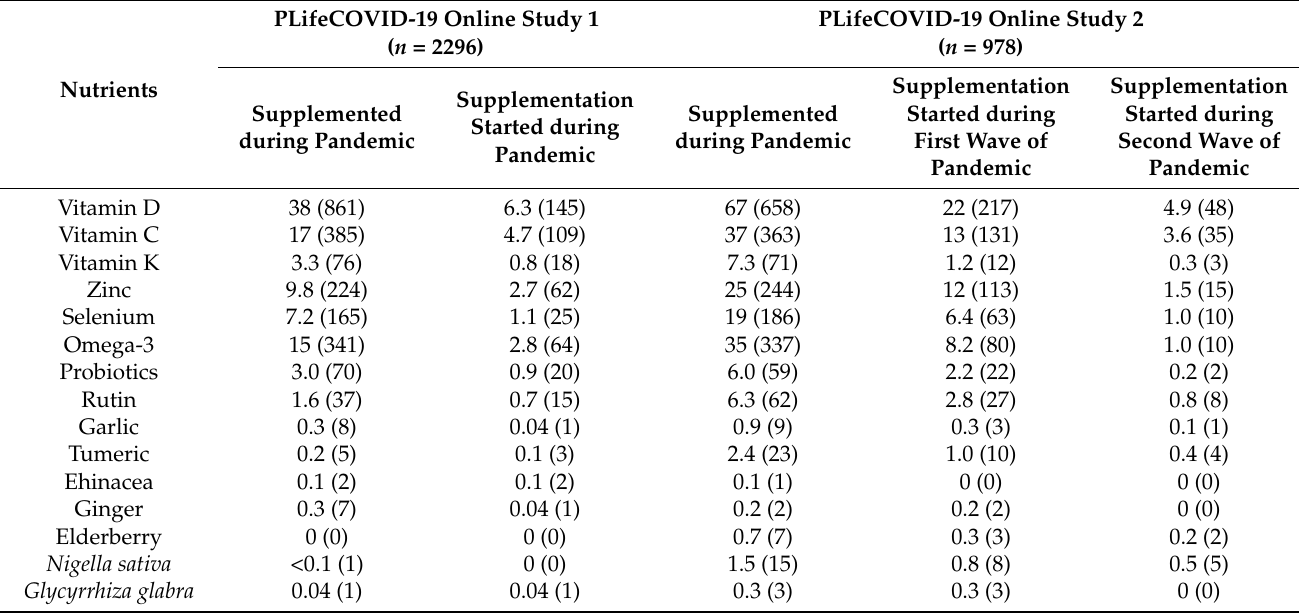
Table 2. Nutrients and bioactive compounds supplemented during the COVID-19 pandemic—results of the PLifeCOVID-19 Online Study 1 and 2.